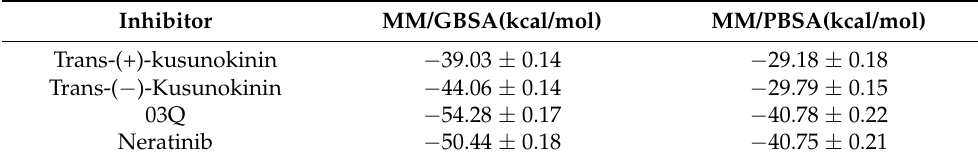
Table 2. Binding energies of ligand-HER complexes obtained from molecular dynamics simulations.